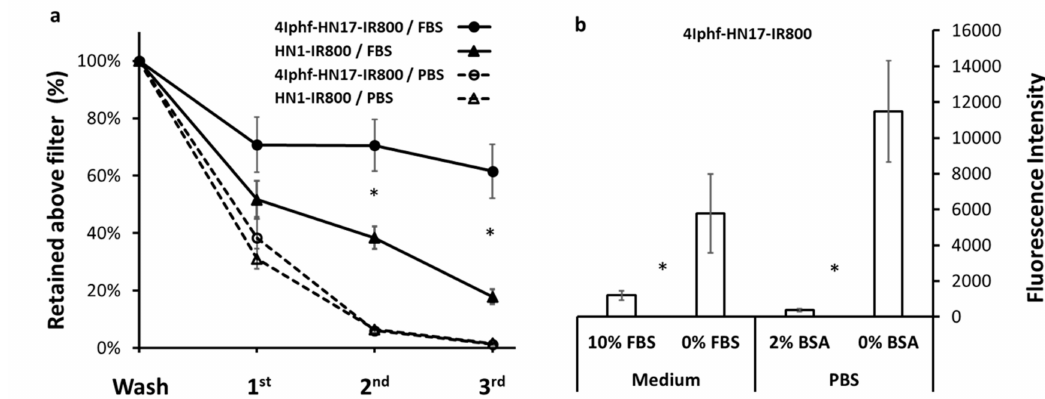
Figure 4. ( a ) Comparison of binding of 4Iphf-HN1-IR800 and HN1-IR800 to proteins in FBS (fetal bovine serum). The horizontal axis refers to the number of washings of the filtered fraction. Bound